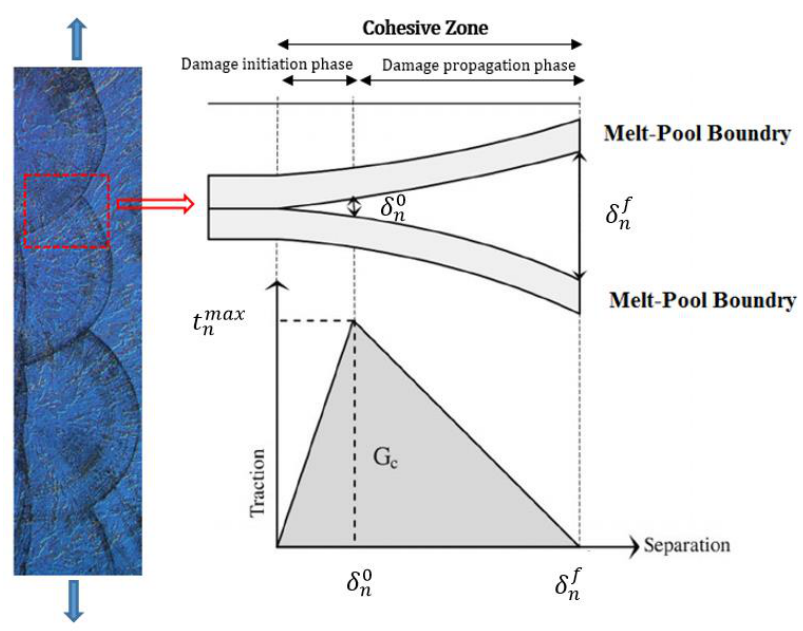
Figure 9. Bilinear traction–separation model on the melt pools domains.